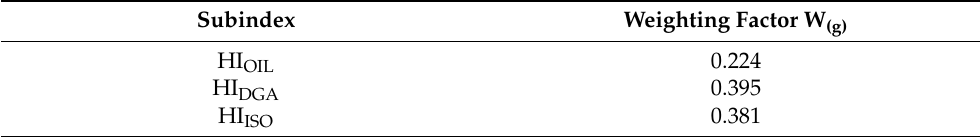
Table 7. The weighting factors of the subindexes used to calculate the total health index value.